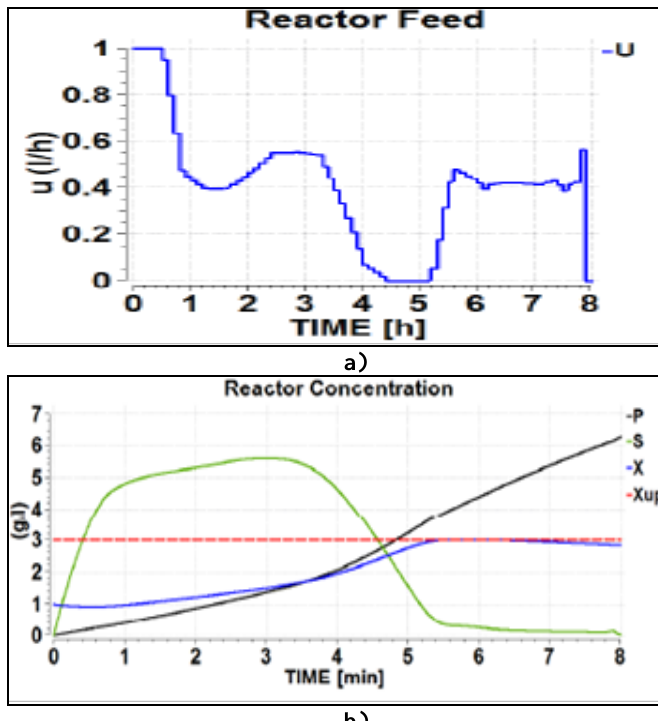
Figure 16: (a) Manipulated and (b) constrained